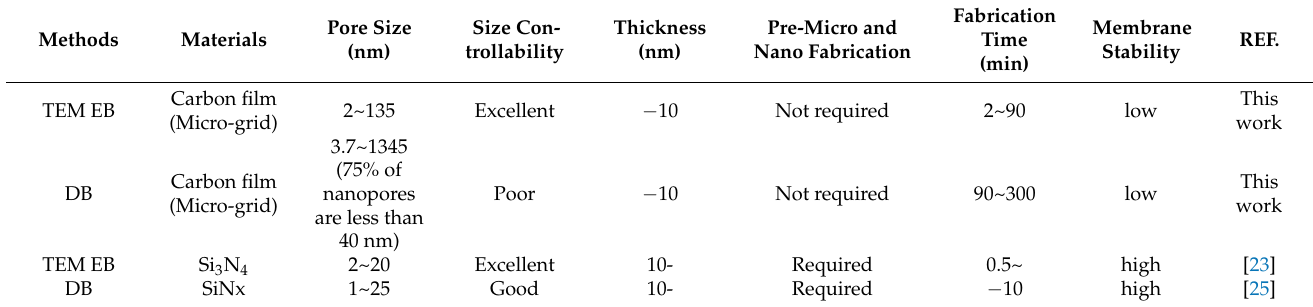
Table 2. Comparison of fabrication methods of solid-state nanopores.